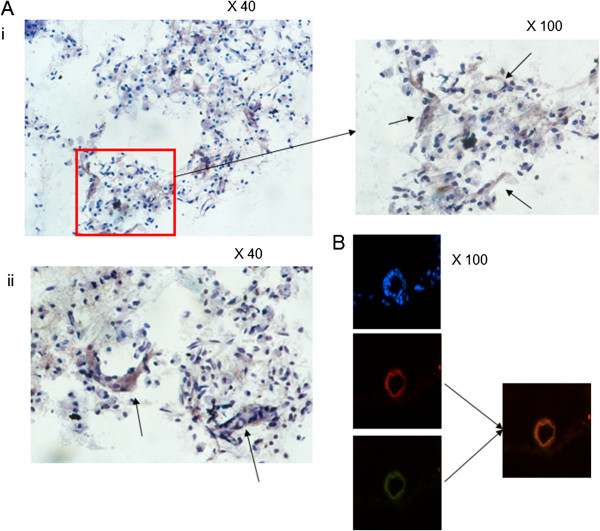
Co-localization of CD105 (TRITC) and p-IRS-1 was seen in microvessels of citicoline-treated animals in stroke regions following MCAO. Ai and ii) IHC staining of citicoline-treated rats (n = 5) demonstrated a notable increase in the staining of stroke-associated microvessels with p-IRS-1 (DAB; brown). Representative staining is shown from one animal at magnifications of x 40 and x 100. Arrows represent positively stained vessels. B) IF analysis demonstrated co-localization of CD105 (TRITC) and p-IRS-1 (FITC) in some of these vessels. In all experiments, control sections were used where the primary antibody was replaced by PBS.